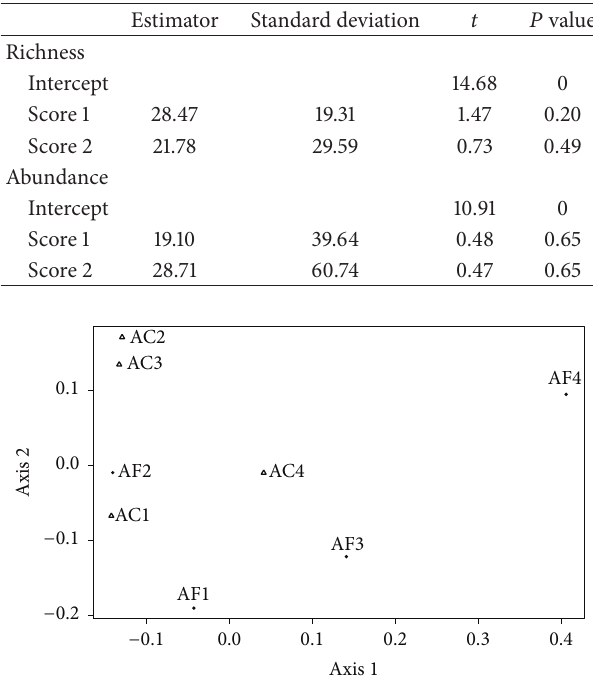
Table 4: Results of the multiple regression of the biotic variables on the species richness of birds in the study area.